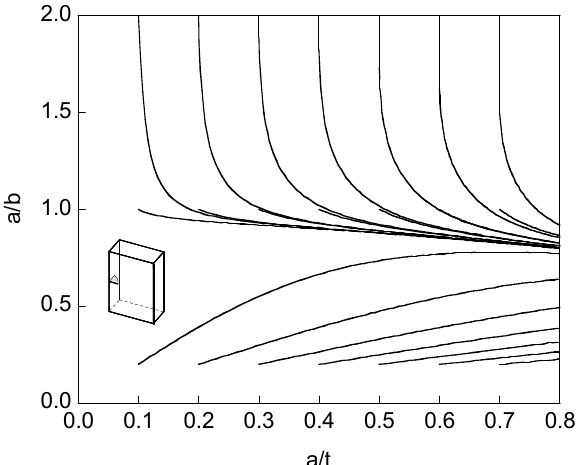
Figure 3. Crack aspect ratio evolution during fatigue propagation in air for cracks emanating from a plate corner.